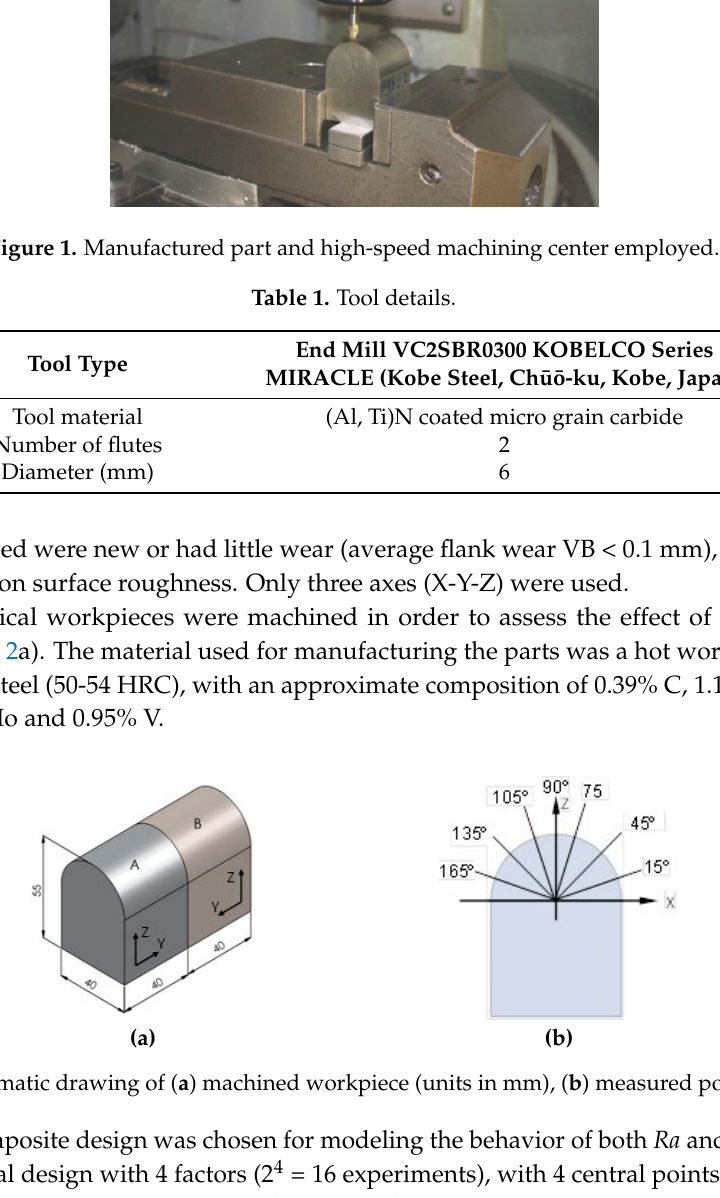
Figure 3. Schematic drawing of milling strategies. ( a ) climb (down) milling; ( b ) conventional (up) milling.